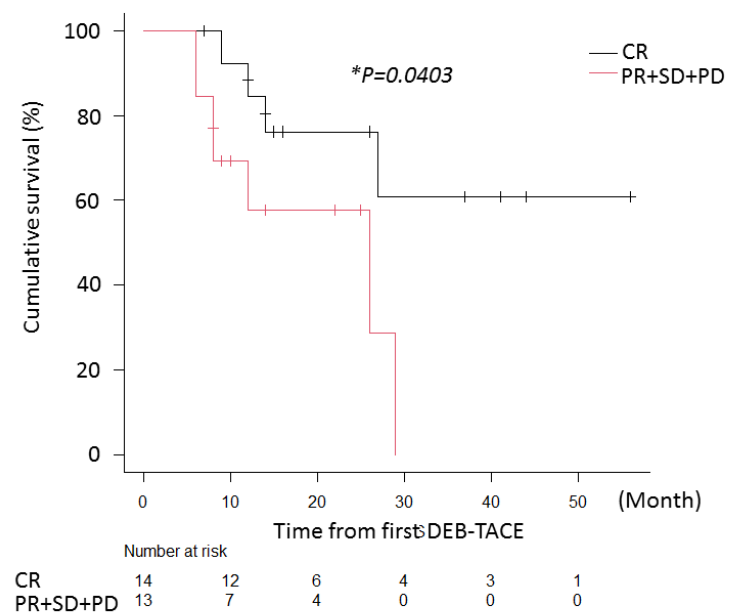
Figure 3. Cumulative rates of overall survival: the Kaplan–Meier method and log-rank test were used to assess the cumulative rates of overall survival. The black line indicates patients within the cTACE group and the red line indicates patients within the non-cTACE group (* p < 0.05). Table 5. Safety profile following the additional cTACE ( n =